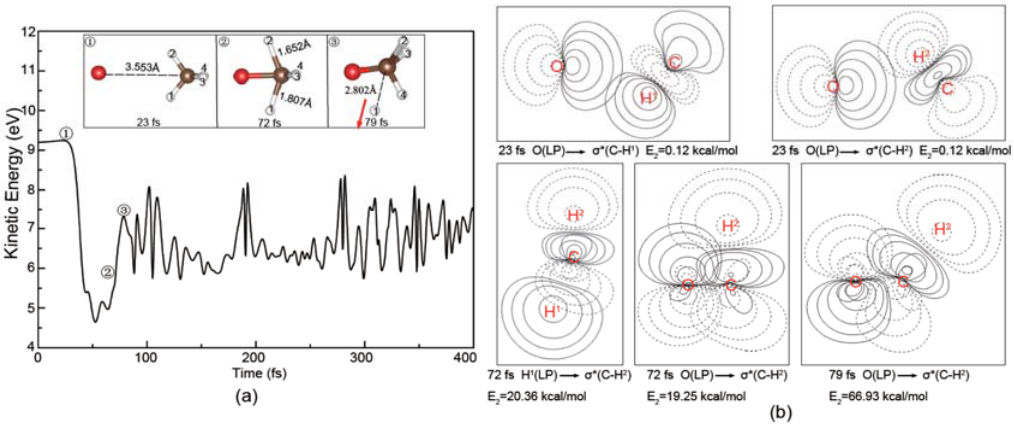
Figure 5. ( a ) Evolution of the total kinetic energy and snapshots in the reaction beginning with the O − center-of-edge-angle attack (9.2 eV); ( b ) The corresponding NBO contour maps at the selected times and E 2 is the hyperconjugative energy. The red arrow in ( a ) shows the translational direction of the product H.